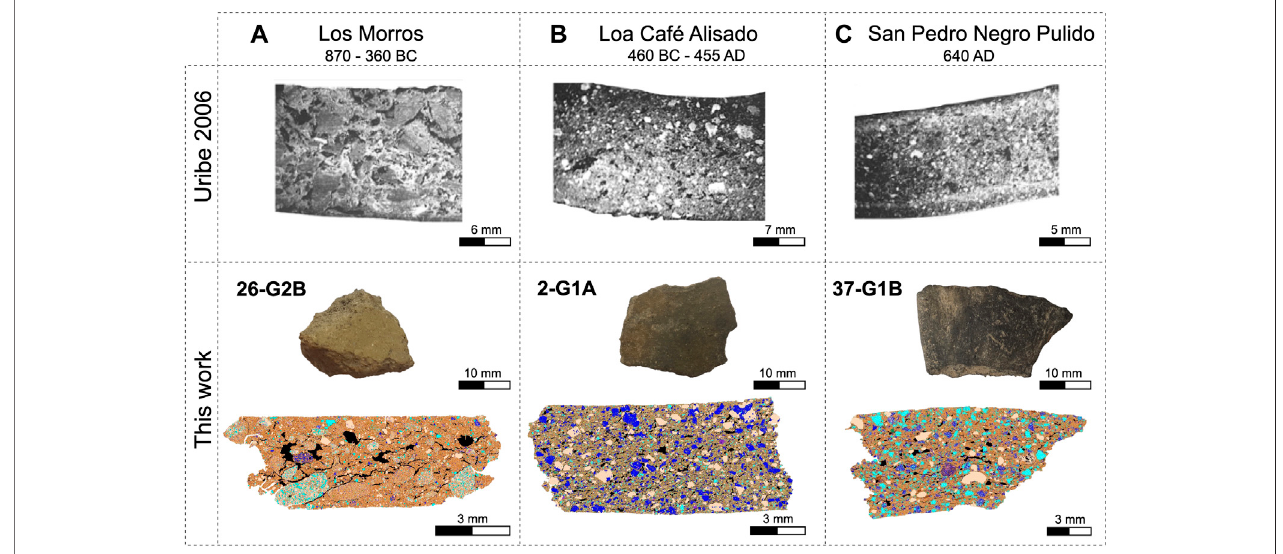
FIGURE 2 | Representative photographs and automated mineralogical maps of the studied sample types: (A) Los Morros (LMS), (B) Loa Café Alisado (LCA) and (C) San Pedro Negro Pulido (NP1). Upper and middle and lower panels show examples of fresh pastes ( after Uribe 2006), ceramic fragments and automated mineralogical maps, respectively. Thermoluminescence dating from Uribe (2006) and Agüero and Uribe (2011).